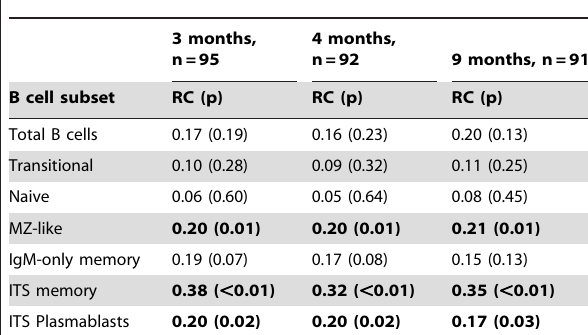
Table 2. Adjusted regression analysis: Baseline B-cell subpopulations as predictors for IgG antibody